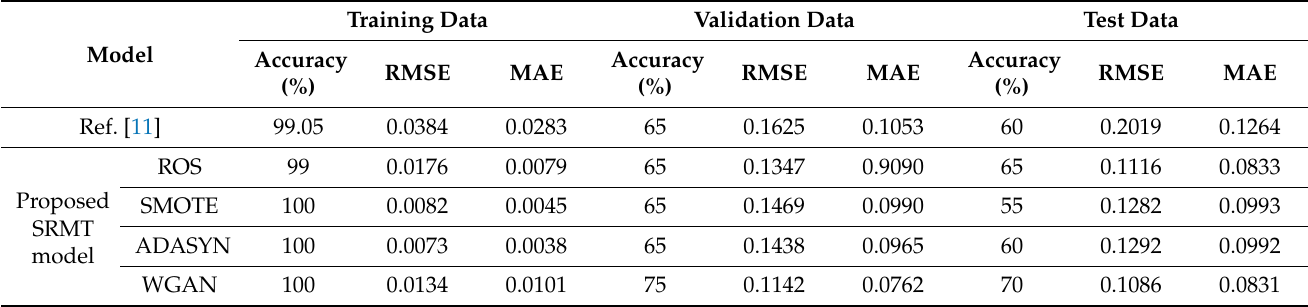
Table 11. Performance comparison between the existing SRMT model [11] and the proposed SRMT model with data augmentation